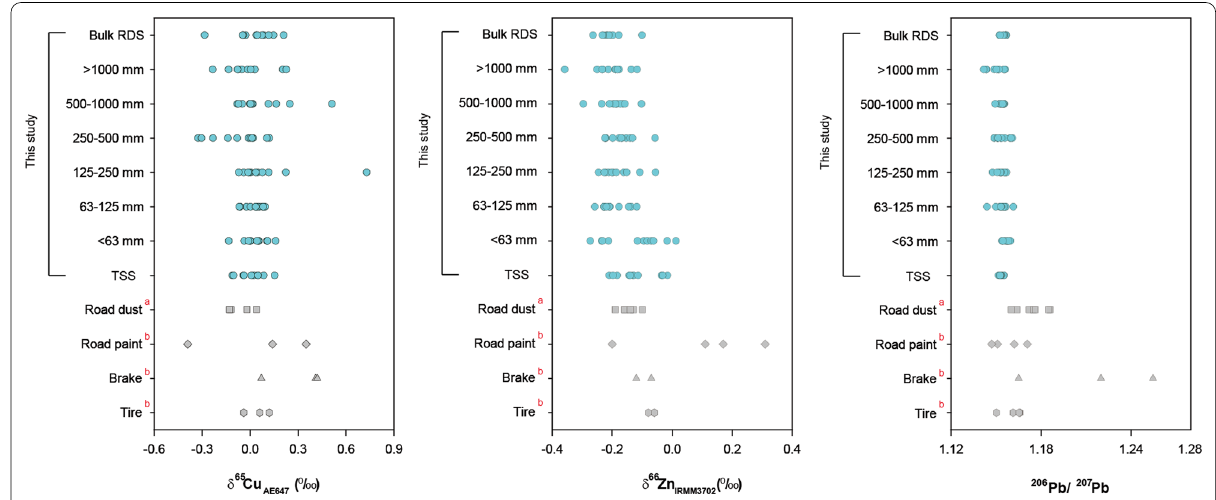
Fig. 4 Comparison of Cu, Zn, and Pb isotopic composition in this study and other literature data ( a Souto-Oliveira et al. 2018; b Dong et al.